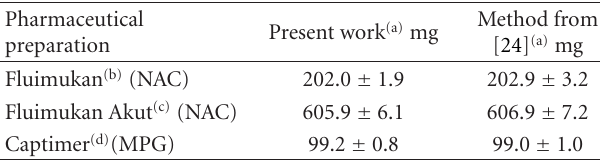
Table 2: Determination of NAC and MPG in their pharmaceutical formulations by the proposed spectrophotometric equilibrium method and by a literature method